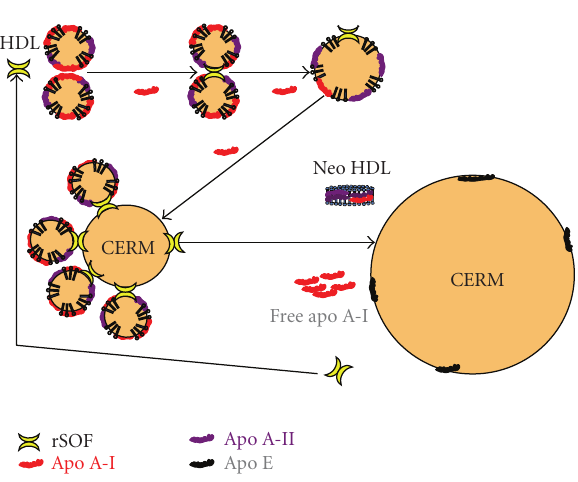
Figure 5: Model of the opacification reaction of SOF with high-density lipoproteins (HDLs). SOF initiates the opacification reaction by binding to HDL. SOF is a heterodivalent fusogen that crosslinks two or more HDL particles and simultaneously induces the release of free apo A-I and promotes the fusion of the resultant particles culminating in the formation of a cholesterol-ester rich microemulsion (CERM) and neo-HDL. Neo-HDL is deficient in free cholesterol/cholesterol esters and rich in phospholipids and apo A-II. Some HDL particles also contain apo E, which is preferentially retained in CERM. Structures are not drawn to scale. CERM particles range from 100 to 500 nm in size whereas HDL particles are ∼ 8.5 nm [38]. Current data indicates one CERM particle contains cholesterol-esters from ∼ 400,000 HDL particles. It is these CERM particles that cause serum to become opaque due to their large size and insolubility in aqueous